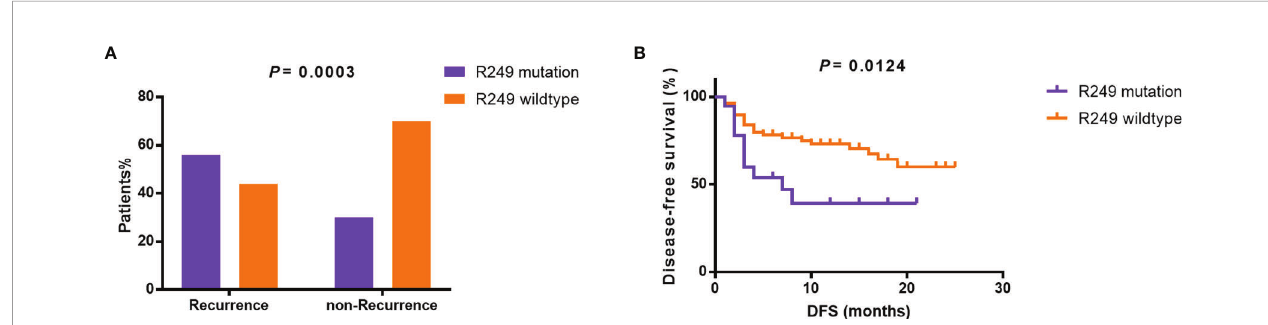
FIGURE 3 | Relationship between TP53 R249S mutation and prognosis. (A) Incidence of R249 mutation in the recurrent and non-recurrent groups. (B) Disease-free survival in the R249 mutation group and the R249 wildtype group. DFS, disease-free